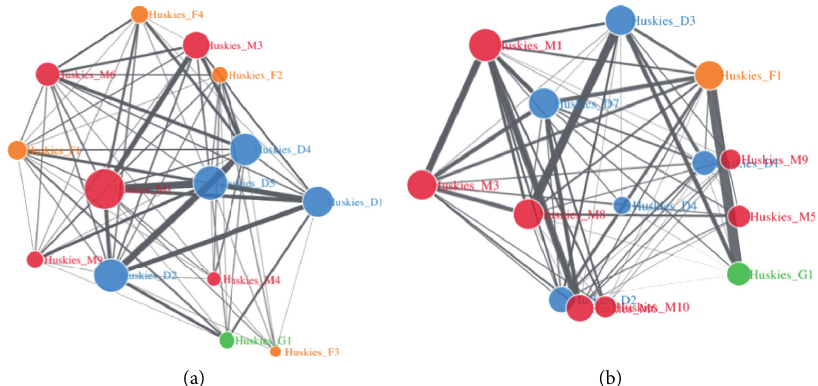
Figure 11: Match 7 (a) and Match 13 (b) passing